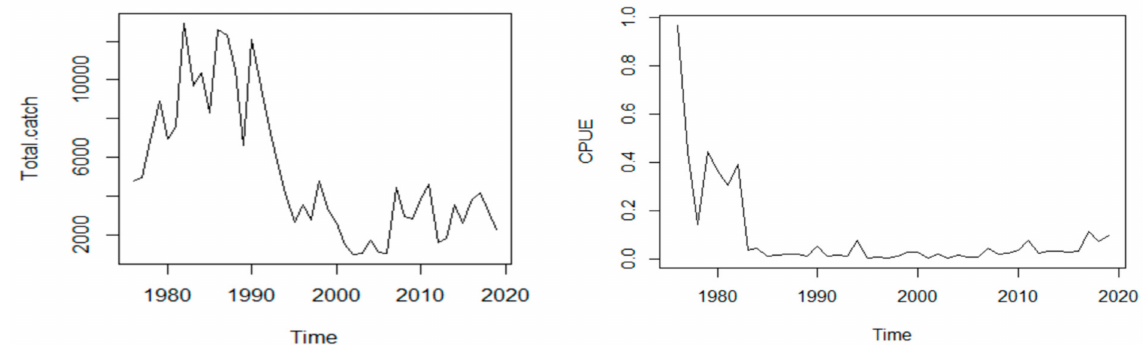
Figure 2. Total biomass landings (tons) and catch per unit effort (kg/h).